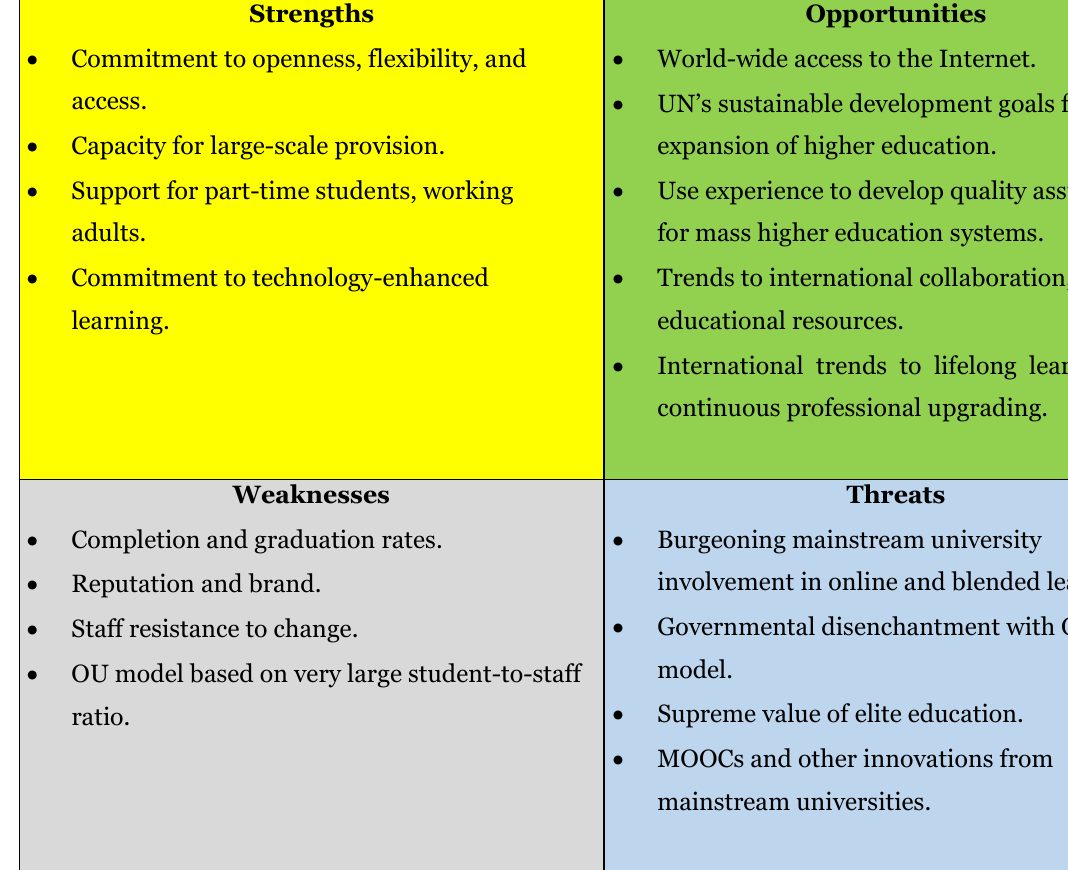
Figure 1. SWOT analysis for open